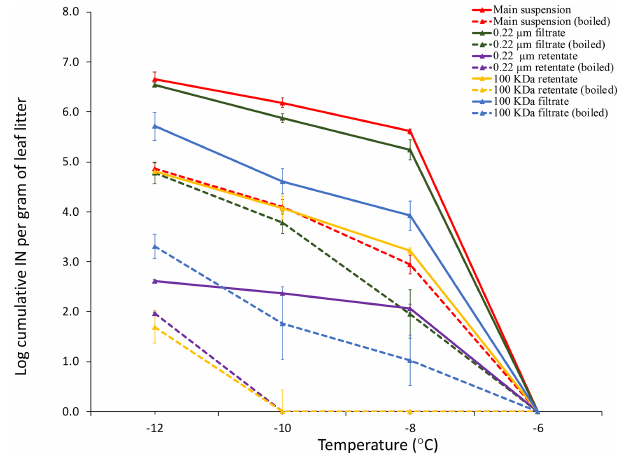
Figure 2. Cumulative ice nucleation spectra of aspen leaf litter sam- ple 70-S-14. Results are shown for all fractions shown in Fig. 1 based on droplet freezing assays at − 6, − 8, − 10, and − 12 ◦ C. IN: ice